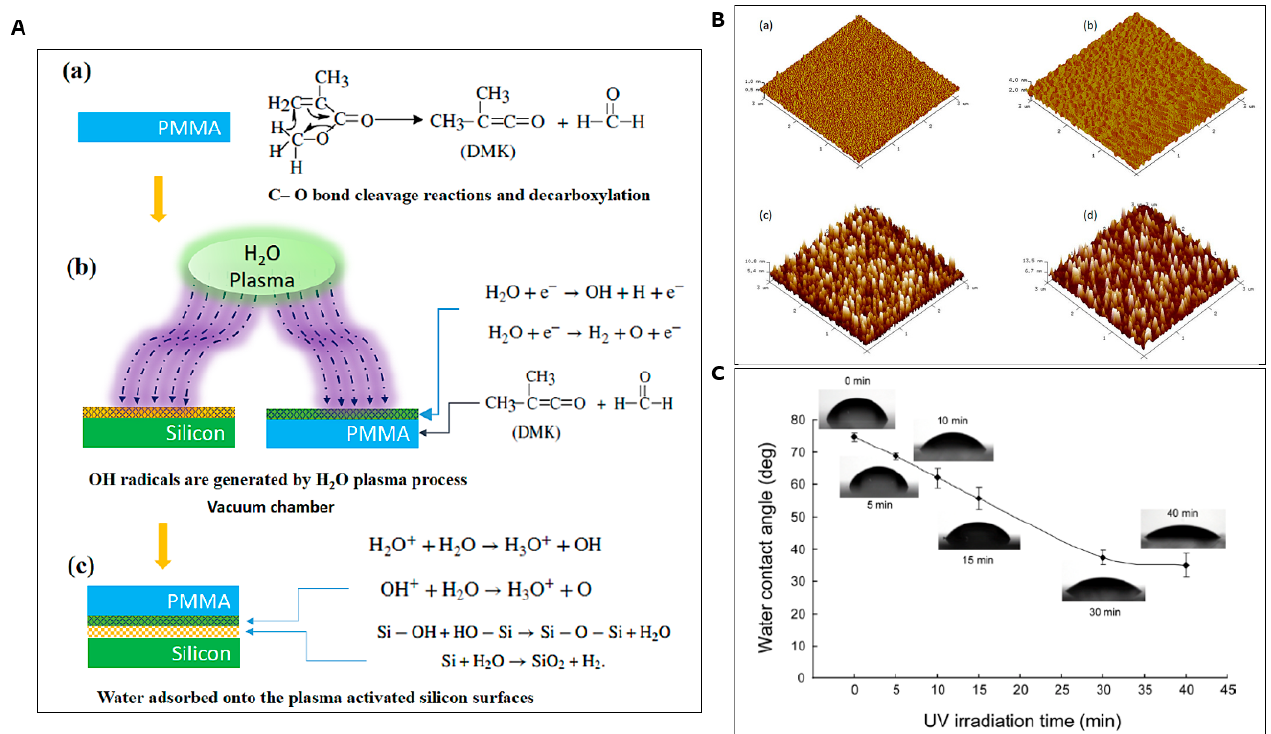
Figure 4. ( A ) Chemical structure of PMMA; chemical reaction during and after H 2 O plasma treatment while bonding between PMMA/silicon substrates [79] . ( B ) Surface roughness of PMMA and silicon before and after H 2 O plasma treatment [79] . ( C ) Water contact angle measured after UV irradiation on the PMMA substrate over time. Reprinted with permission from ref. [84] . Copyright 2015 IOP Publishing Ltd.